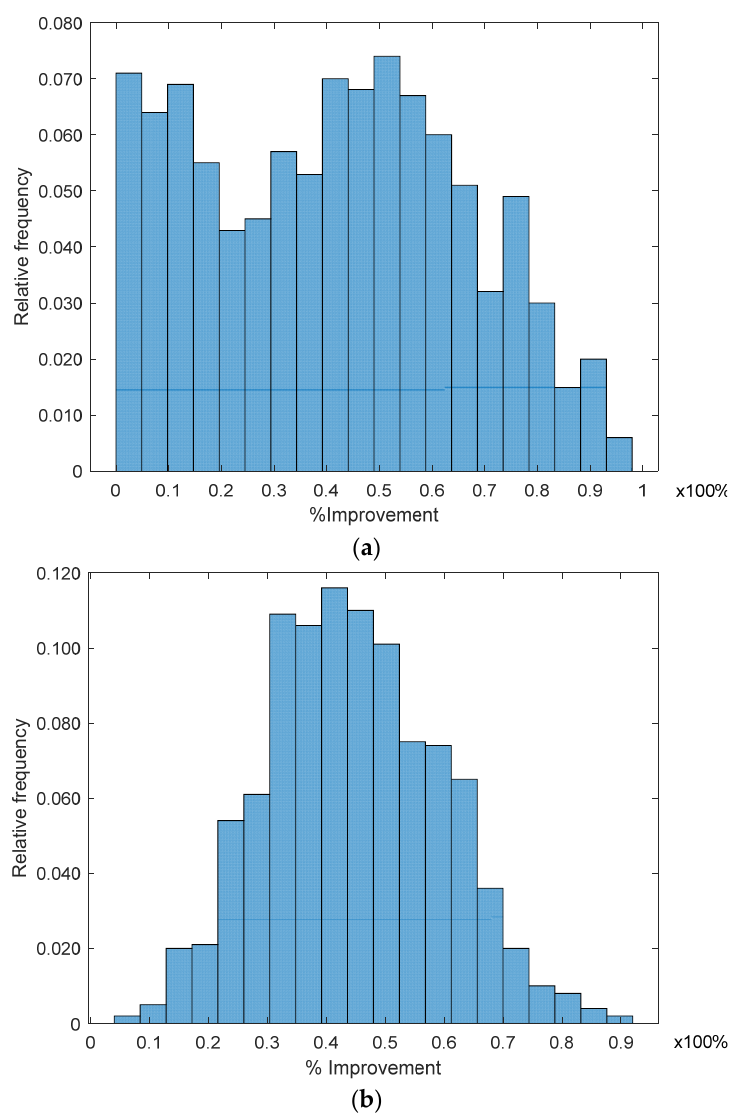
Figure 5. Improvement histogram achieved using RL: ( a ) single AN and ( b ) mean 3 ANs.